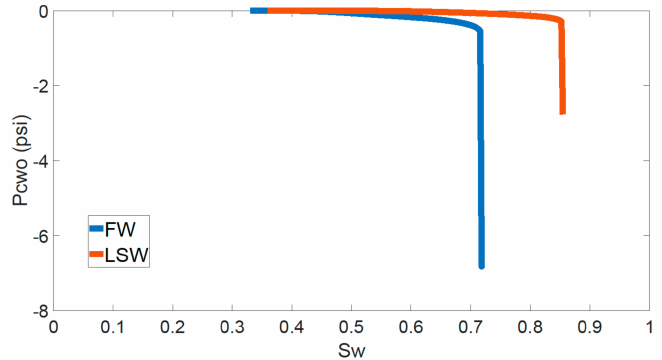
Figure 13. FW and LSW extracted capillary pressure